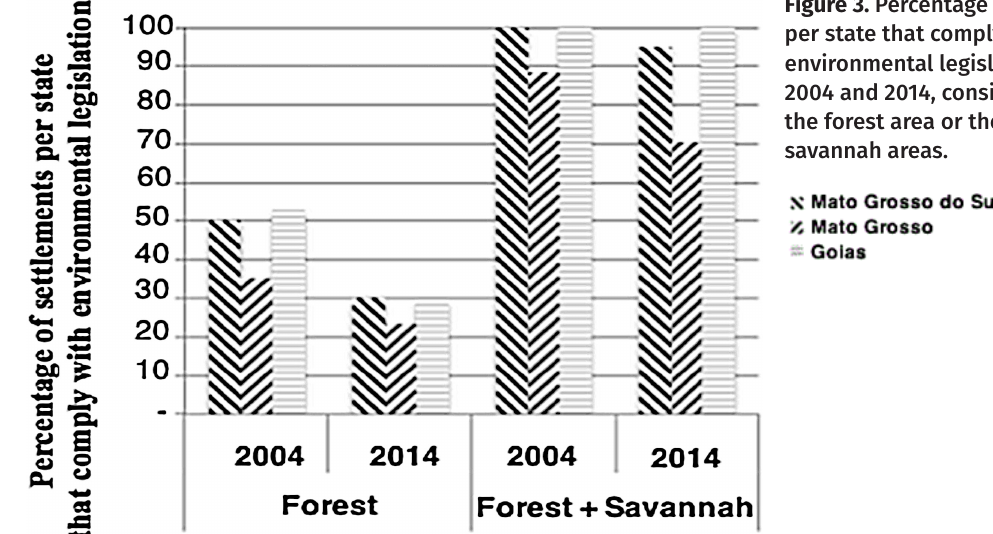
Figure 3. Percentage of settlements per state that comply with environmental legislation, in 2004 and 2014, considering only the forest area or the forest and savannah